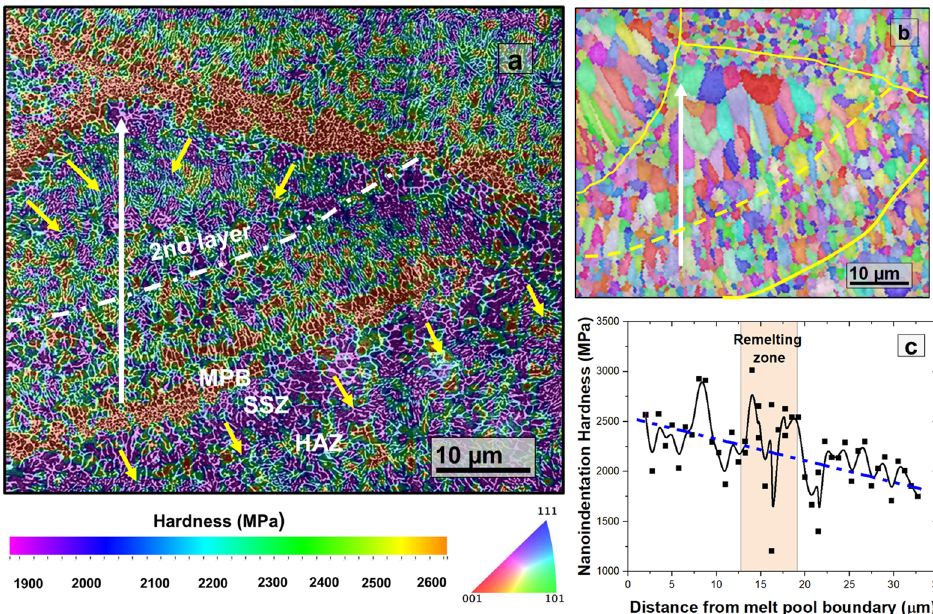
Figure 3. Micromechanical-microstructural correlation within single melt pool ( a ) Hardness map combined with immersion mode BSE image of a single melt pool, ( b ) EBSD map reveals a strong grain size relationship with solidification, and ( c ) nano-hardness trends reveal the influence of complex thermokinetics behavior of L-PBFAM process. The yellow arrows represent the direction of heat extraction from